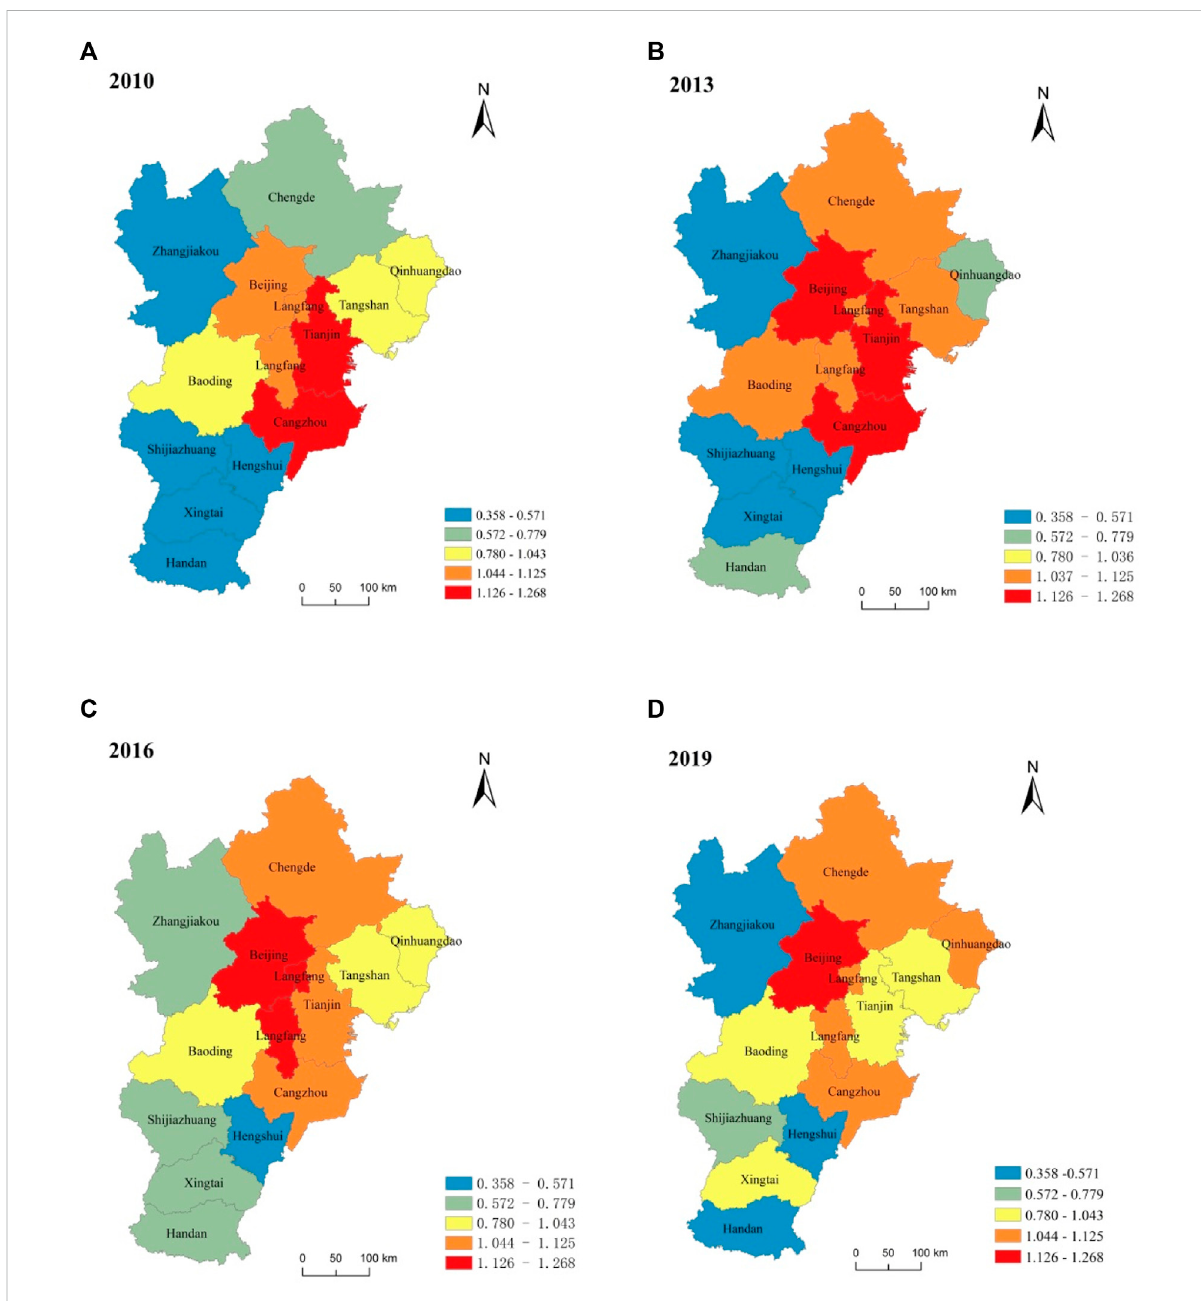
FIGURE 3 Spatial distribution of tourism eco-ef fi ciency in the Beijing-Tianjin-Hebei